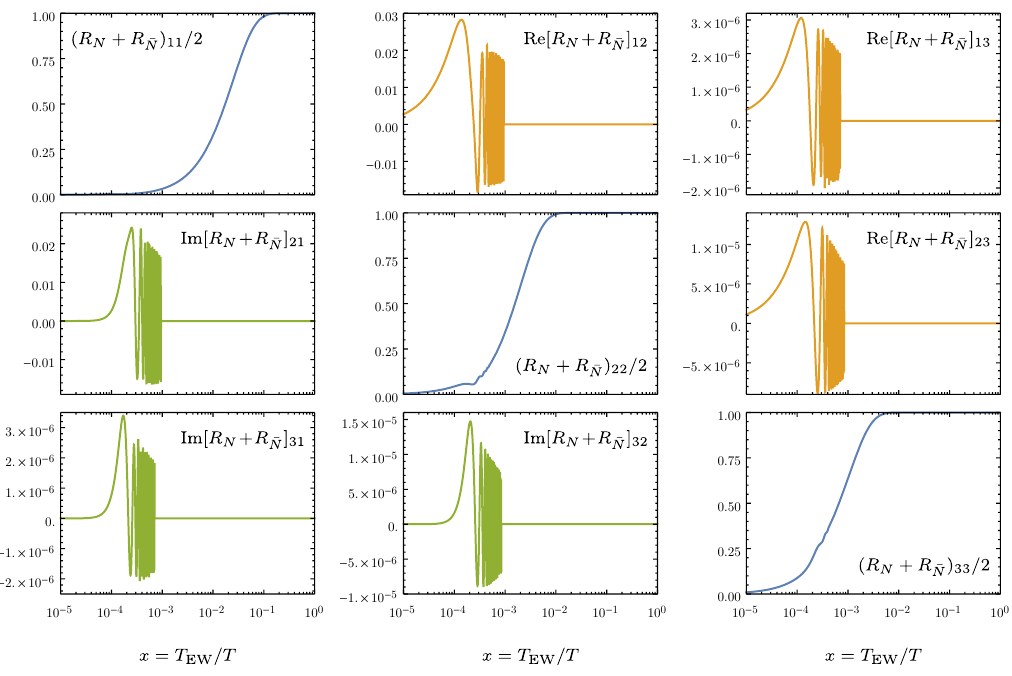
Figure 9 . Entries of the density matrix for benchmark point III). The o(cid:11)-diagonal elements of the density matrix are set to zero (i.e. oscillations are switched o(cid:11)) after 10 completed oscillations; we checked that this has no signi(cid:12)cant e(cid:11)ect on the asymmetries because they \average out" at later